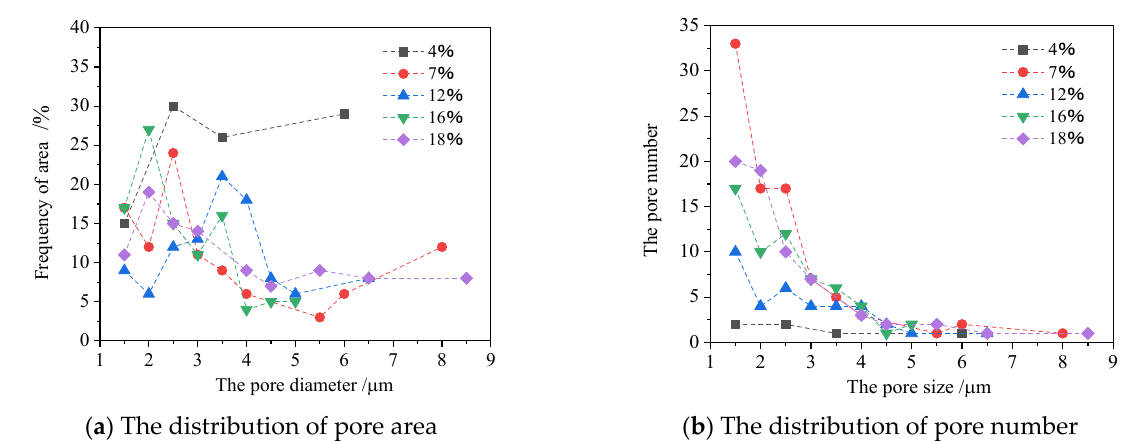
Figure 5. Microstructure characteristics of N-1 under different absorption conditions.